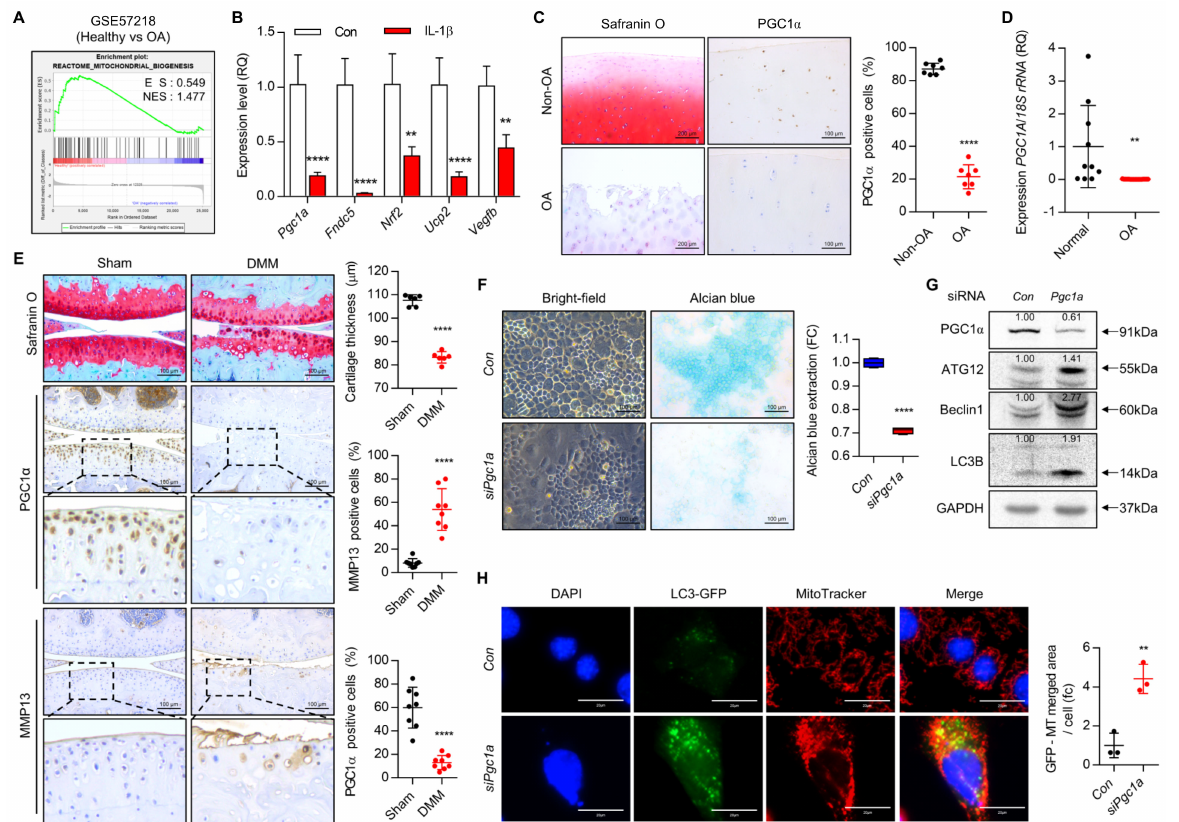
Figure 1. PGC1 α is a key regulator for OA pathogenesis. ( A ) Gene set enrichment analysis (GSEA) of GSE57218 (seven healthy chondrocytes vs. 33 OA chondrocytes). ( B ) Transcription level of Pgc1a and its target genes were analyzed using qRT-PCR ( n = 3). ( C ) Representative images of Safranin O and PGC1 α staining in human Non-OA and OA cartilage, and ratio of PGC1 α positive cells ( n = 7; Scale bars, Safranin O = 200 µ m, PGC1 α = 100 µ m). ( D ) The transcription level of Pgc1a in human normal and OA chondrocytes was analyzed using qRT-PCR (Normal n = 10; OA n = 17). ( E ) Representative images of Safranin O, PGC1 α , and MMP13 in mouse sham and DMM cartilages (Scale bars. Cartilage thickness ( n = 6) and positive cells for MMP13 and PGC1 α ( n = 8) were counted. ( F ) Representative images of cell morphology and alcian blue staining ( n = 5; Scale bars, 100 µ m). Alcian blue staining extracted with 6M guanidine-HCl was measured in 600 nm absorbance ( n = 4). ( G ) Translation level of PGC1 α , ATG12, Beclin1, LC3B with the introduction of siPgc1a into iMACs. The GAPDH antibody was used for loading control. Each protein level was measured using ImageJ software and normalized by GAPDH expression level and indicated by fold change. ( H ) Representative images of LC3-GFP puncta and MitoTracker in Con and siPgc1a transfected iMACs ( n = 5; Scale bars, 20 µ m). Results are representative of at least three independent experiments. Values were expressed as means ± s.d. An unpaired t -test or one-way ANOVA was used for statistical analysis. ** p < 0.01, **** p <